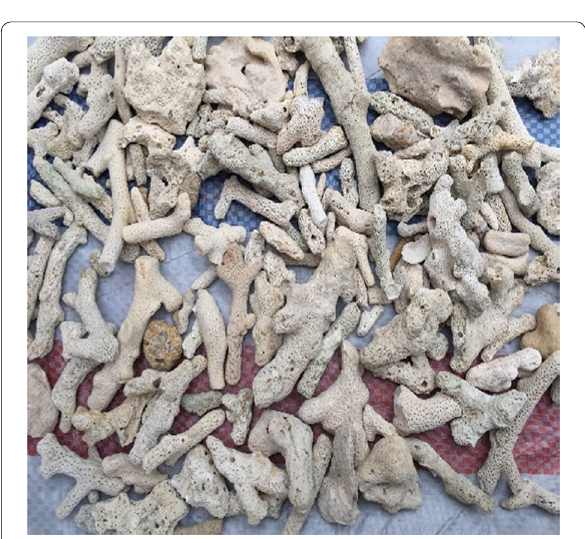
Fig. 2 Coral aggregate.